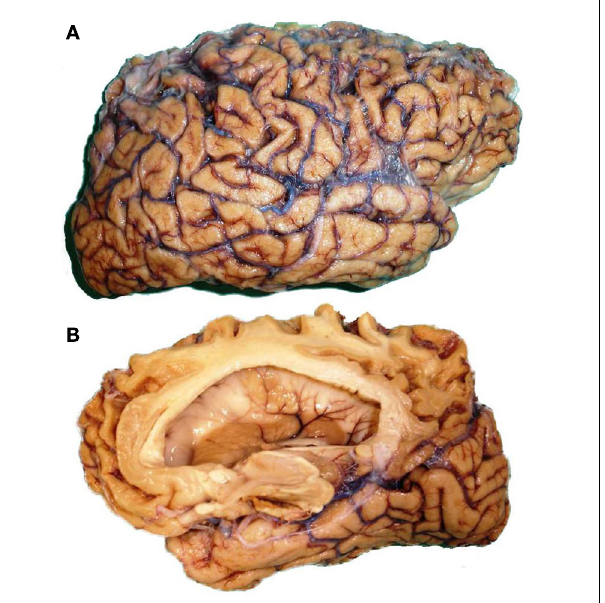
FIGURE 3 | Macroscopical findings of a FTLD–TDP brain. Lateral (A) and medial view (B) showing cortical atrophy that involves frontal, temporal, and parietal lobes, with better preserved sensorimotor cortex and occipital